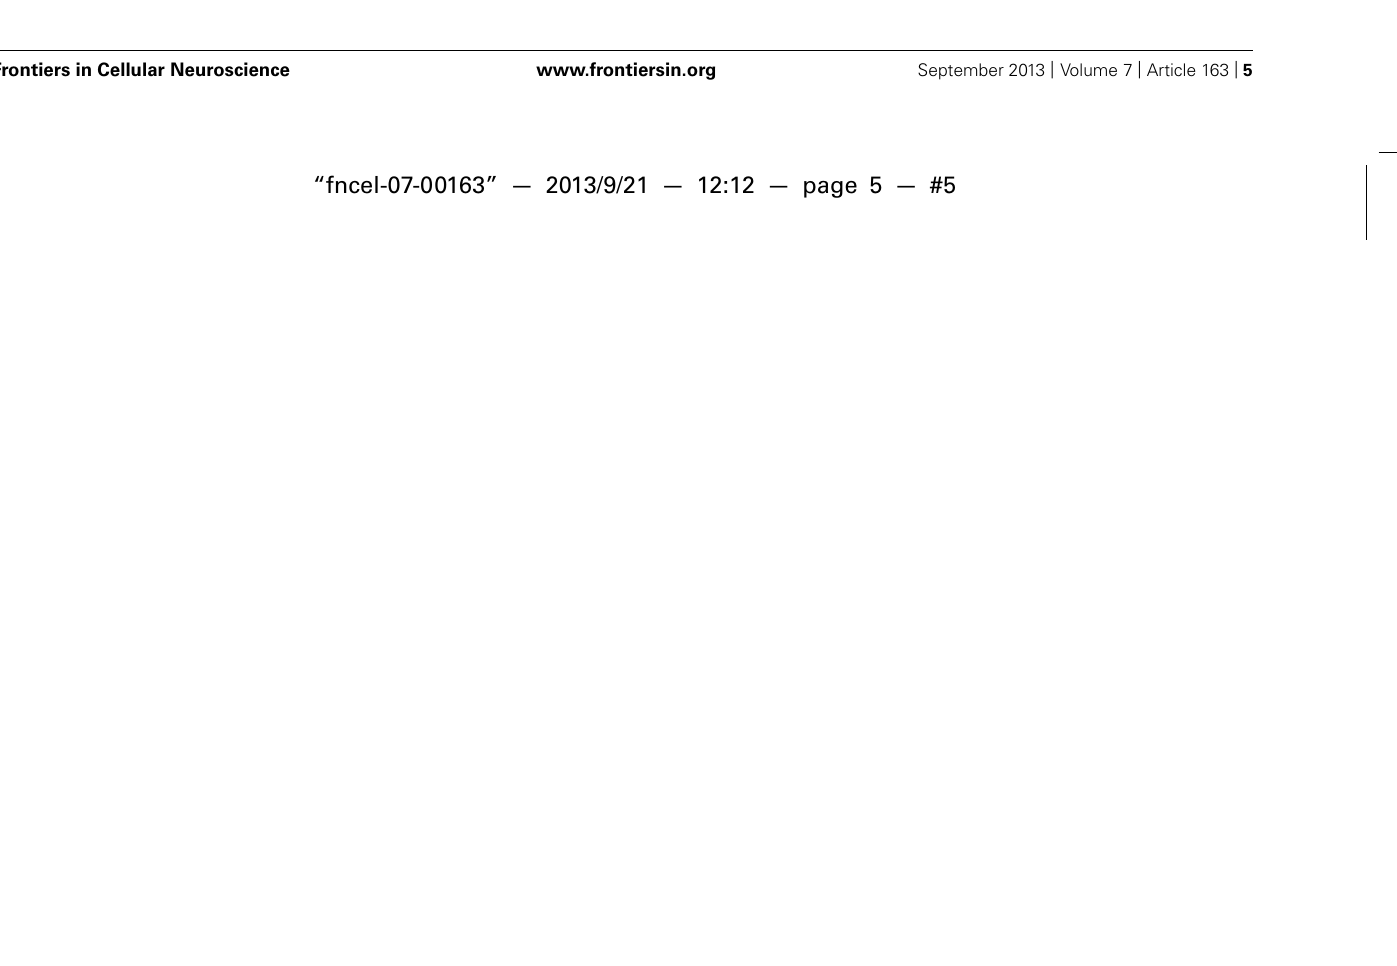
FIGURE 3 |Target protectors are transcribed and effective in vitro . (A) Schematic vector map of the 60 nt target protector in pcDNA3.1. (B) The 60 nt target protector and control target protector DNA were detected by Northern blot assays at the expected size. No target protector was detected in RNA extracted from empty vector-transfected cells. (C,D) The endogenous protein